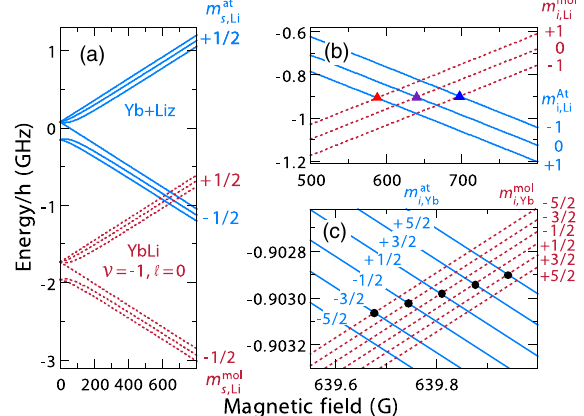
FIG. 1. Three views of the hyperfine and Zeeman energies of 173 Yb- 6 Li zero-energy scattering and bound states as functions of magnetic field in units of G, where 1 G is 0.1 mT. Panel (a) shows H the atomic energies, eigenvalues of H , by solid blue Li þ Yb lines and those of the most weakly bound s -wave bound states, eigenvalues of H 0 , by dashed red lines. Panel (b) shows an enlargement of the level crossing region near 640 G in (a). Panel (c) is a further enlargement of the crossing region but now shows R Þ with red dashed lines. bound-state energies of H 0 þ U s − i ð Symbols in (b) and (c) mark the level crossings for the MFRs observed in this work. Differences in bound-state energies of R Þ would only be visible on the Hamiltonians H 0 and H 0 þ U s − i ð scales used in